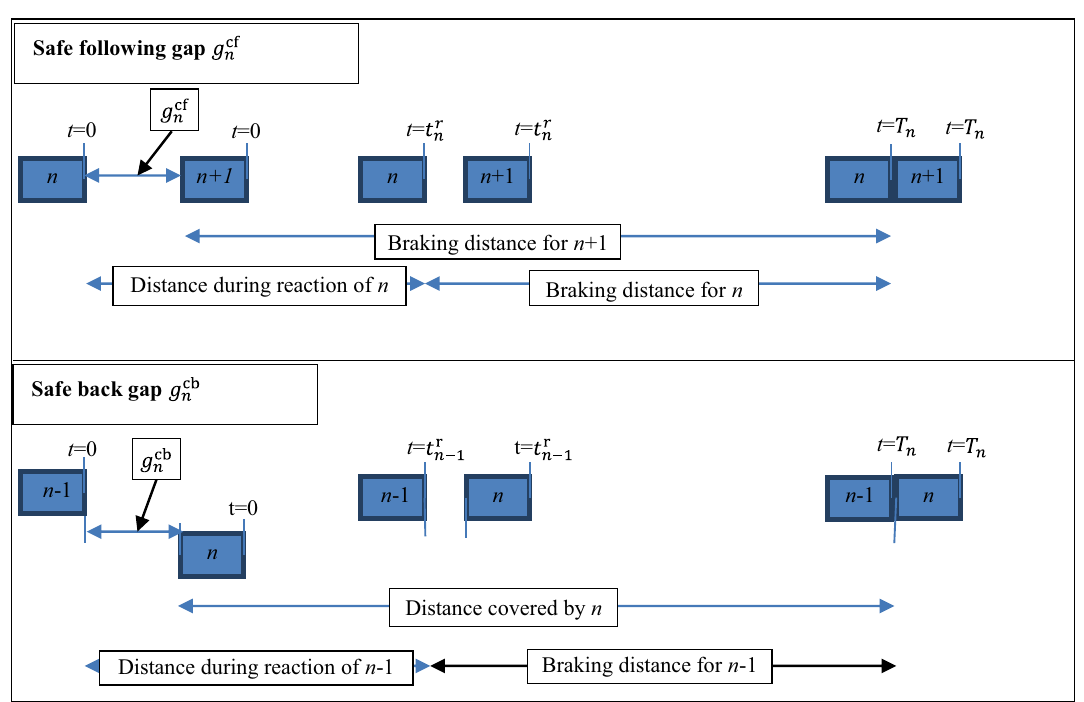
Fig. 4 Safe distance while following and lane